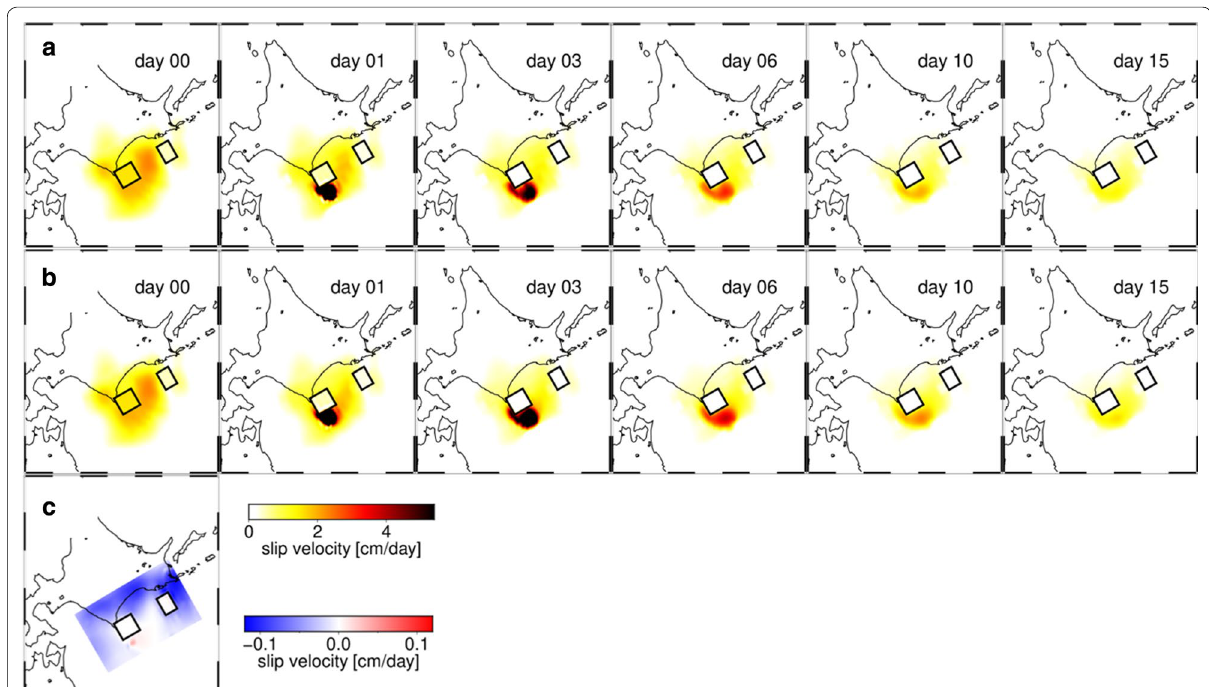
Fig. 10 History of afterslip following the 2003 Tokachi-oki earthquake. The spatio-temporal evolutions are calculated by using the optimized frictional parameters a without and b with the optimization of the initial velocities on day 00. c The difference in the initial slip velocities between a